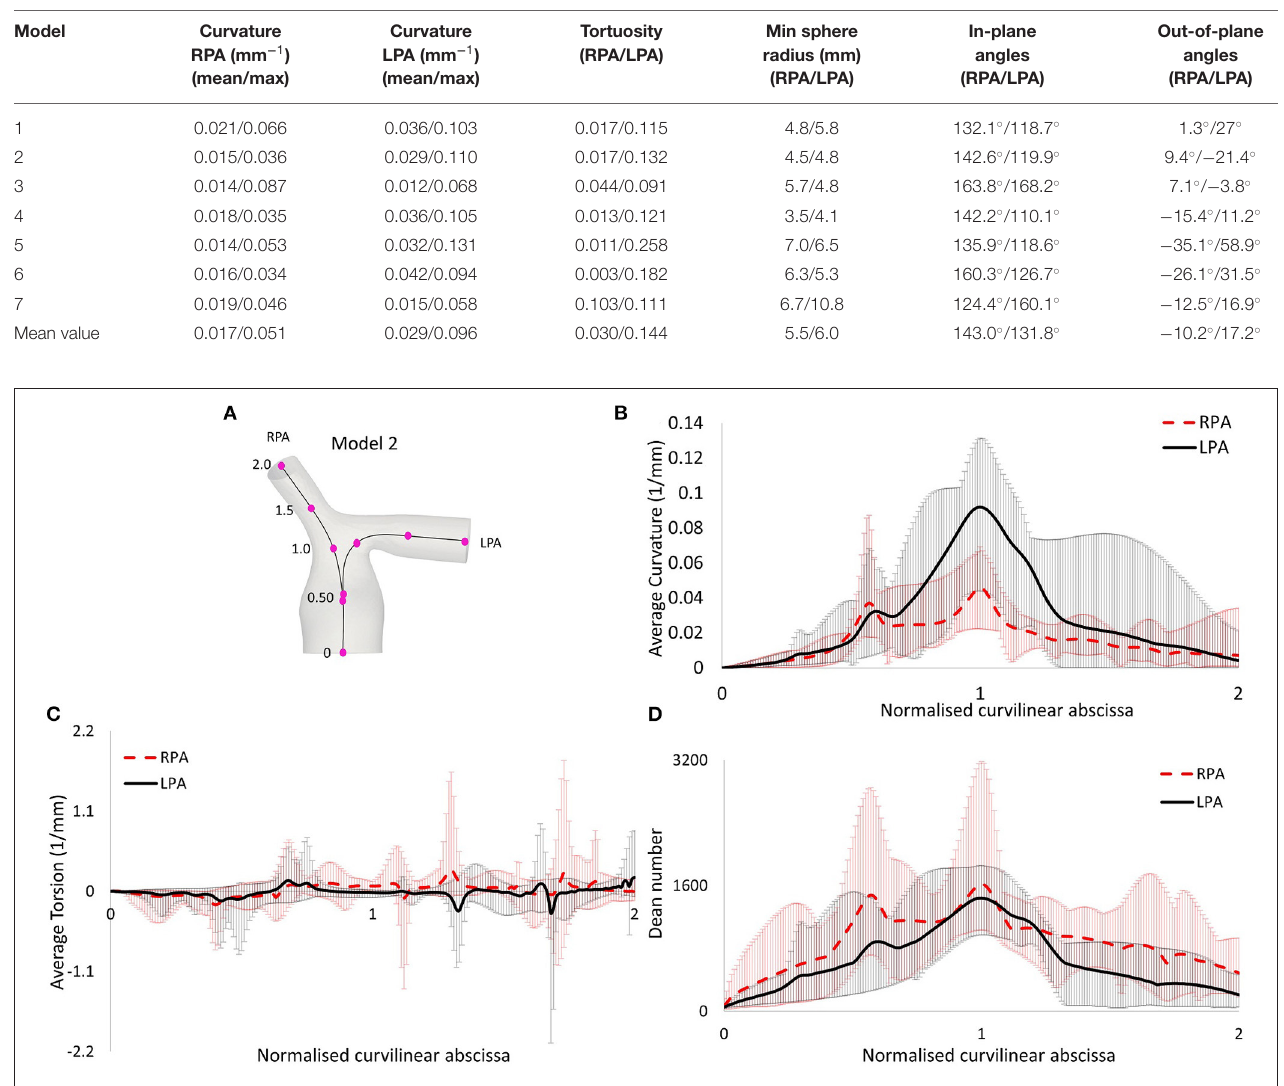
FIGURE 4 | (A) Centerlines along the LPA and RPA of model 2, with points indicating the curvilinear abscissa, normalized by the distance corresponding to the peak curvature value closer to the bifurcating branches. Therefore, the value of 1.0 represents the location of peak curvature for each branch. (B) Average curvature plot. (C) Average torsion plot, and (D) Average Dean number plot, with x -axis indicating distance from point